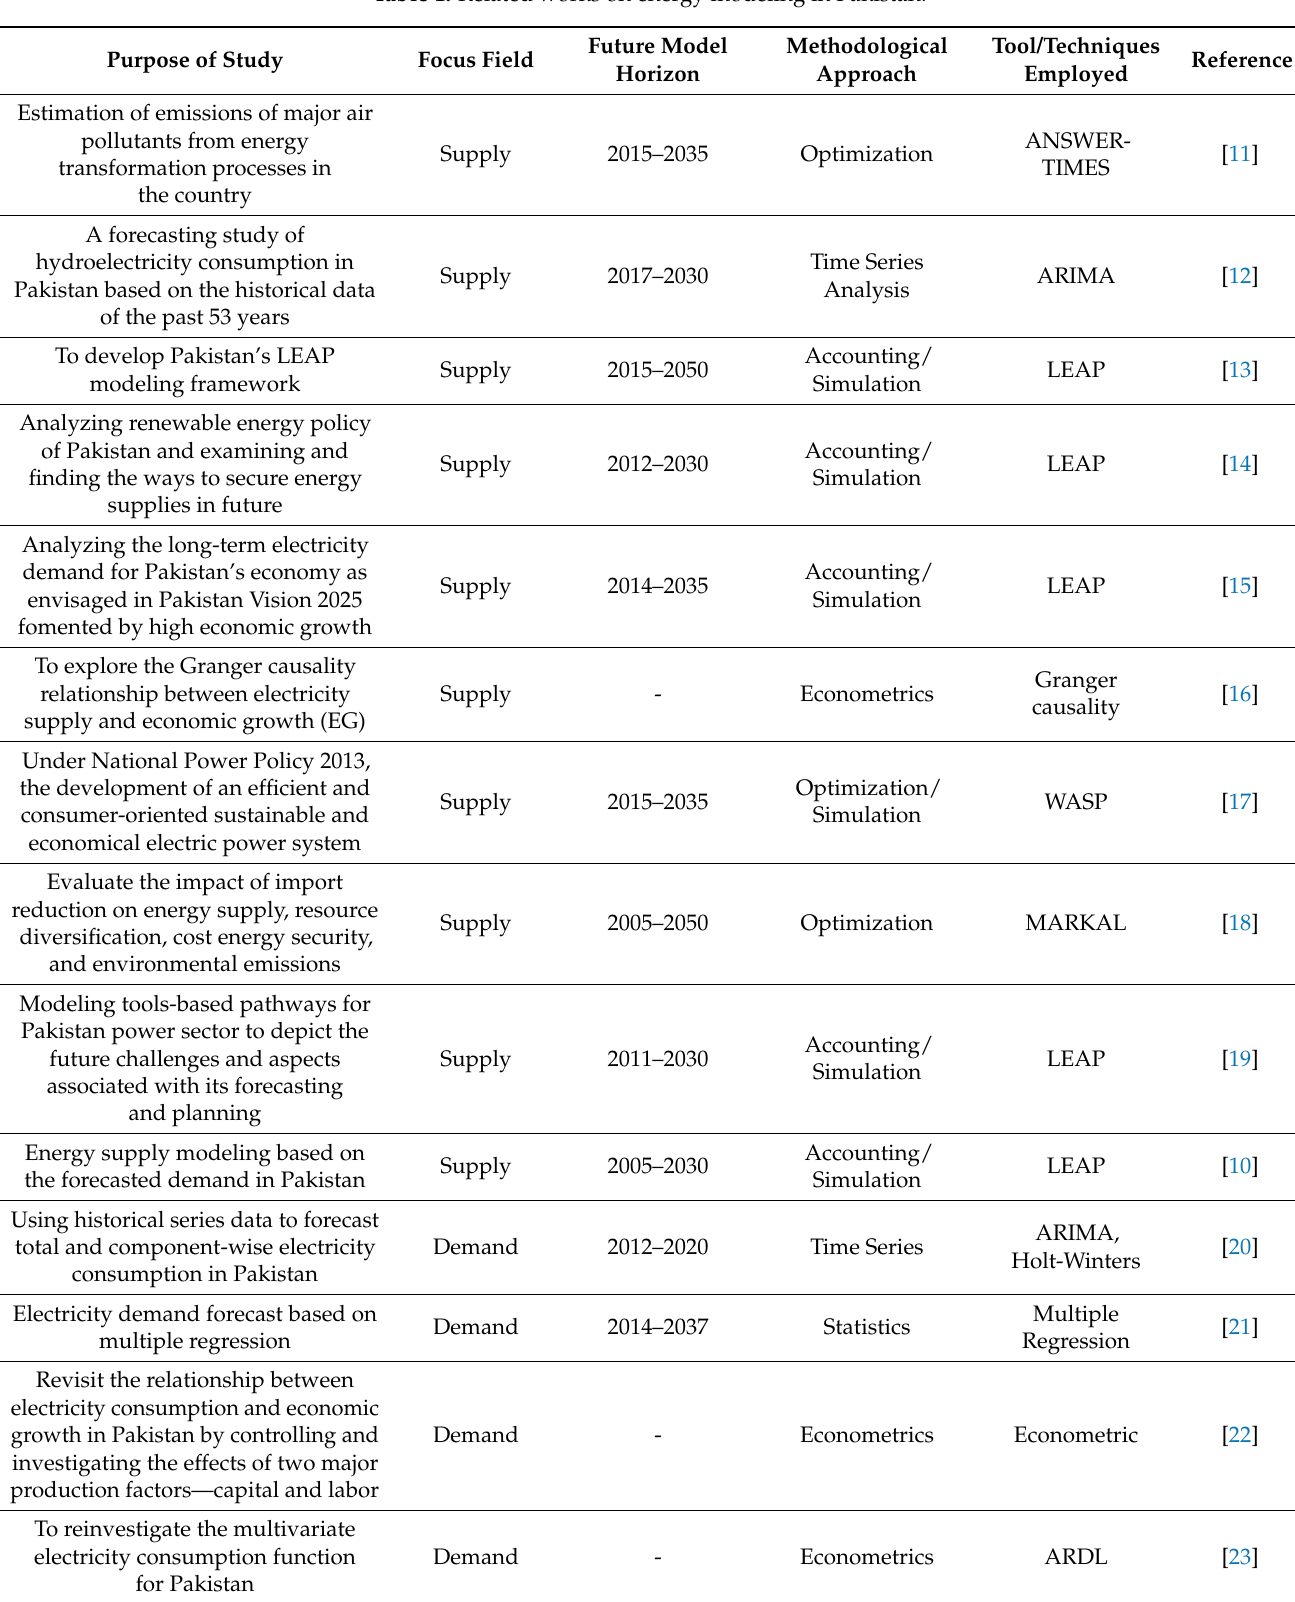
Table 1. Related works on energy modeling in